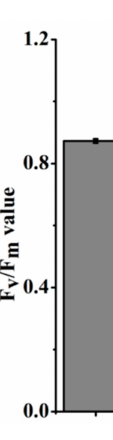
Figure 6. Detection of chlorophyll flouresence between the WT and the pl6 mutant at the tillering stage. All values are the mean ± SD of three biological replications. * p < 0.05 by Tukey’s test.